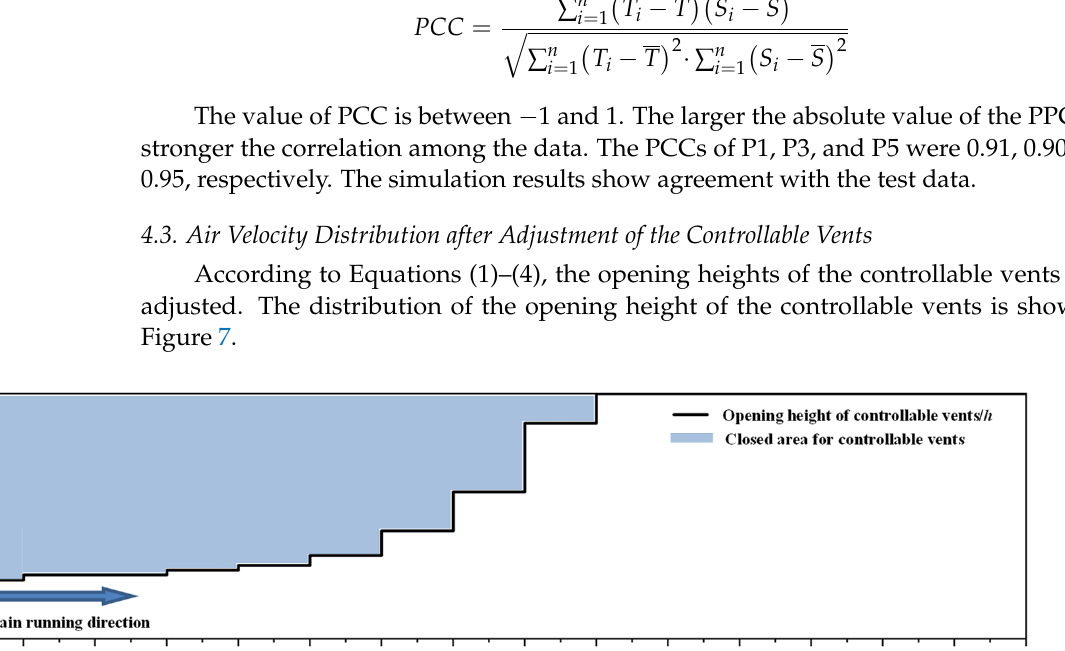
Figure 8. Air velocity distributions along the length of the platform: ( a ) Comparison of air velocity distribution before and after adjustment of the controllable vents. ( b ) Air velocity contour at the controllable vents before adjustment. ( c ) Air velocity contour at the controllable vents after adjustment. As shown in Figure 8, the air velocity distribution was improved. In particular, the air velocities of the controllable vents located at the positions of 60–105 m of the platform were increased. Taking the controllable vent at 90 m as an example, the air velocity was increased from less than 0.5 m/s before adjustment to approximately 1.75